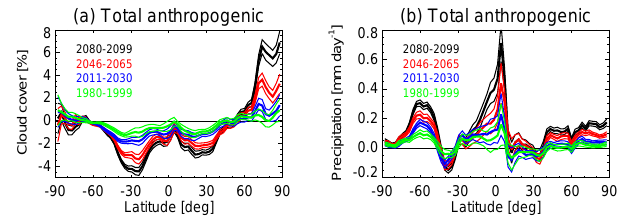
Fig. 16. Zonal annual mean (a) cloud cover and (b) precipitation change in 1980–1999 (green), 2011–2030 (blue), 2046–2065 (red) and 2080–2099 (black) from total anthropogenic forcing. The thick lines indicate the best estimate, the thin lines indicate the 95% con- fidence interval.